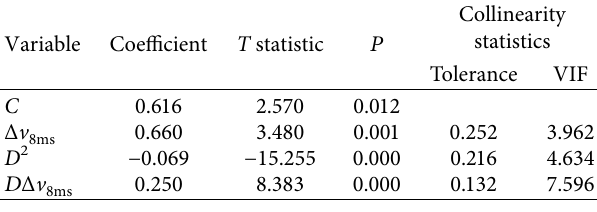
Table 18: Significance of coefficients of the adjusted model (mean velocity variation in a certain window width).